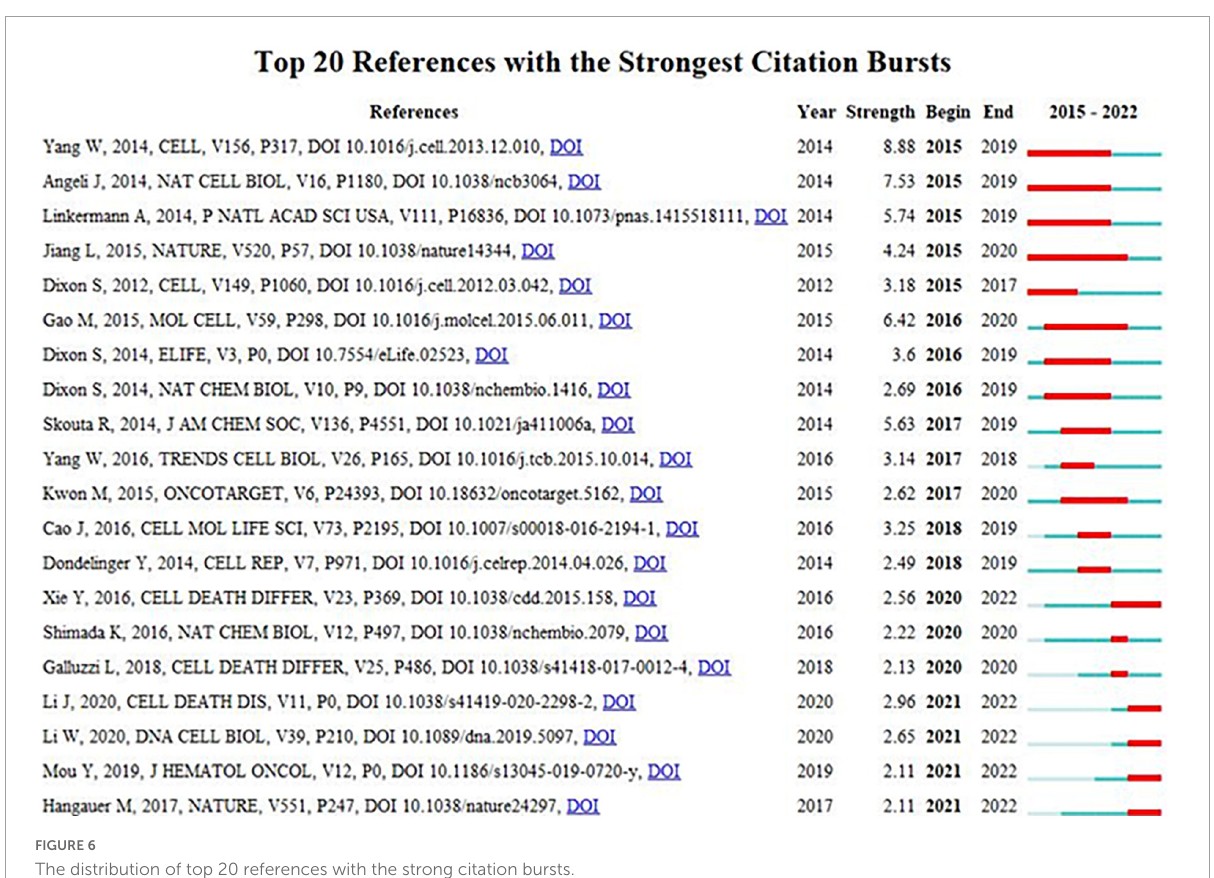
FIGURE6 The distribution of top 20 references with the strong citation bursts.